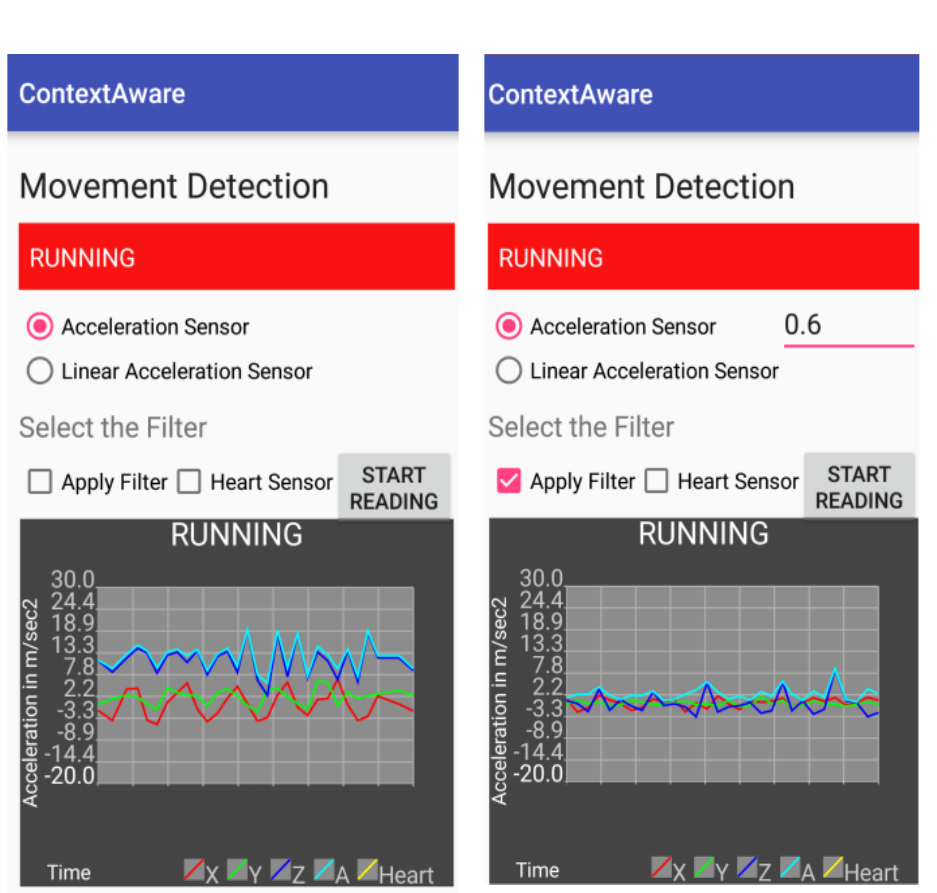
Figure 6. Accelerometer Data for Activity Running (left without ILPF, right with ILPF)